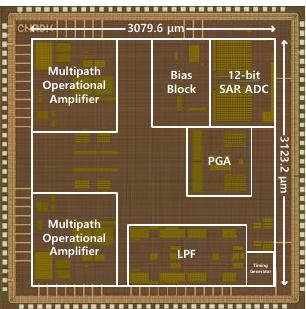
Figure 7. Photograph of the fabricated die, SAR: successive approximation register.